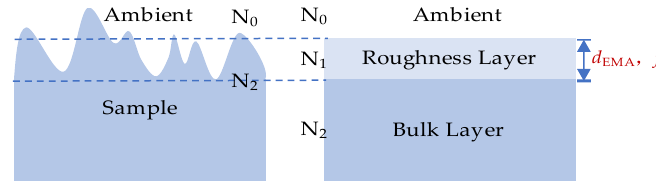
Figure 2. Schematic diagram of the EMA model.